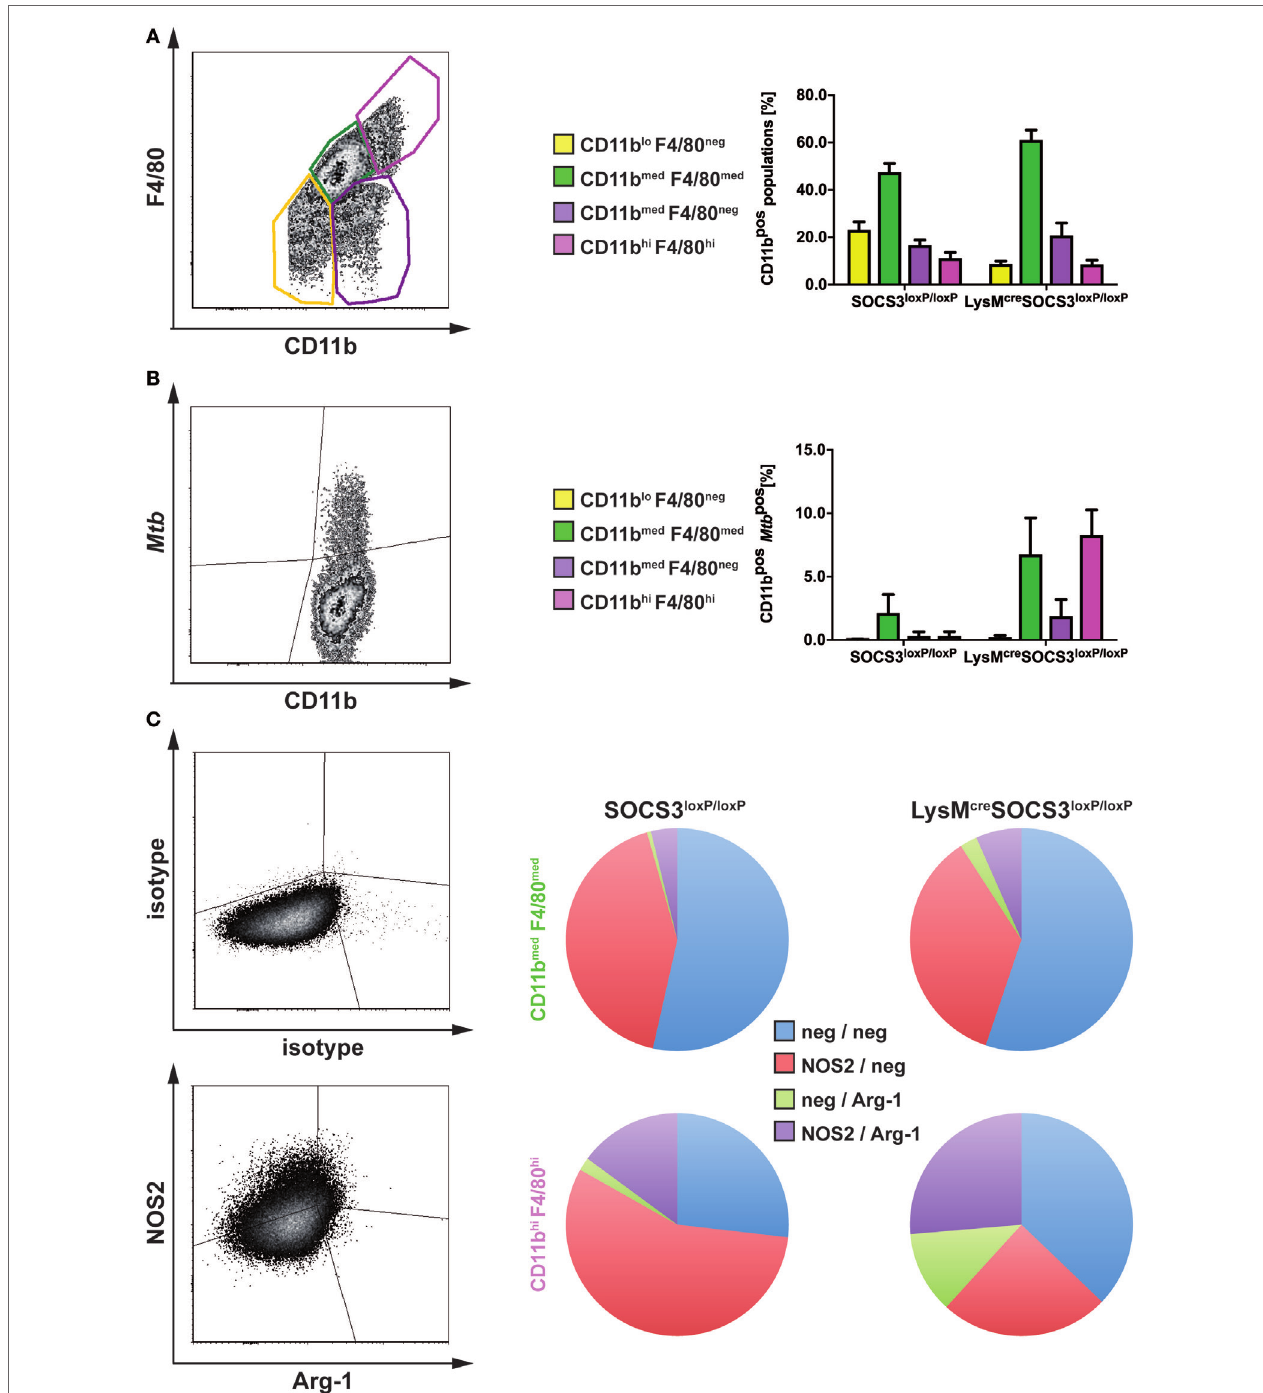
( Figure 5A ). Infection of experimental mice with recombinant Mtb expressing mCherry enabled us to track bacteria in